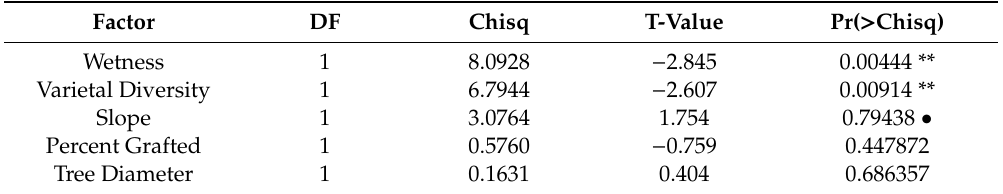
Table 3. Results of LMM model exploring the e ff ect of significant factors on average plot disease severity as continuous variable. AIC = 216. Factors displayed in order of e ff ect size in Figure 4b. Significance indicated as *** representing 0, ** representing 0.001, * representing 0.01, and • representing 0.05. DF is degrees of freedom. Pr is probability.